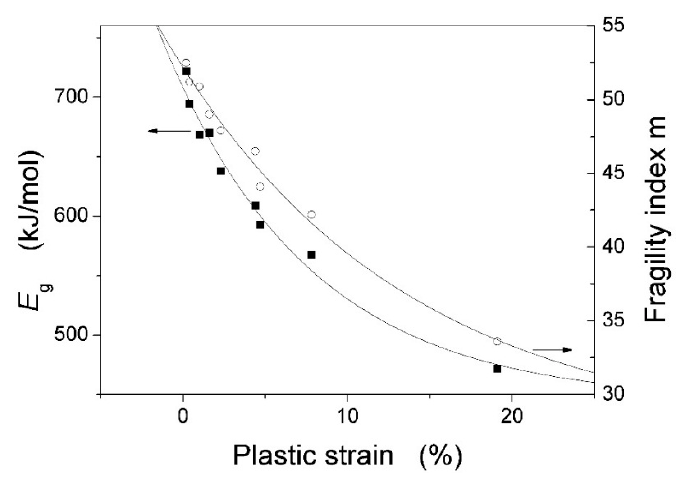
Figure 16. Dependences of the plastic strain on the E g and the m for the studied Zr-based